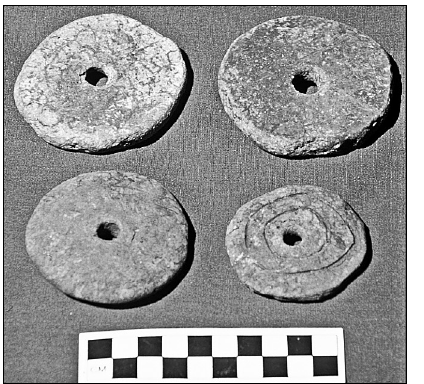
Figure 4 A Pre-ceramic hearth exca- vated at Belmont, c. 600 BC (arrow scale 10cm).